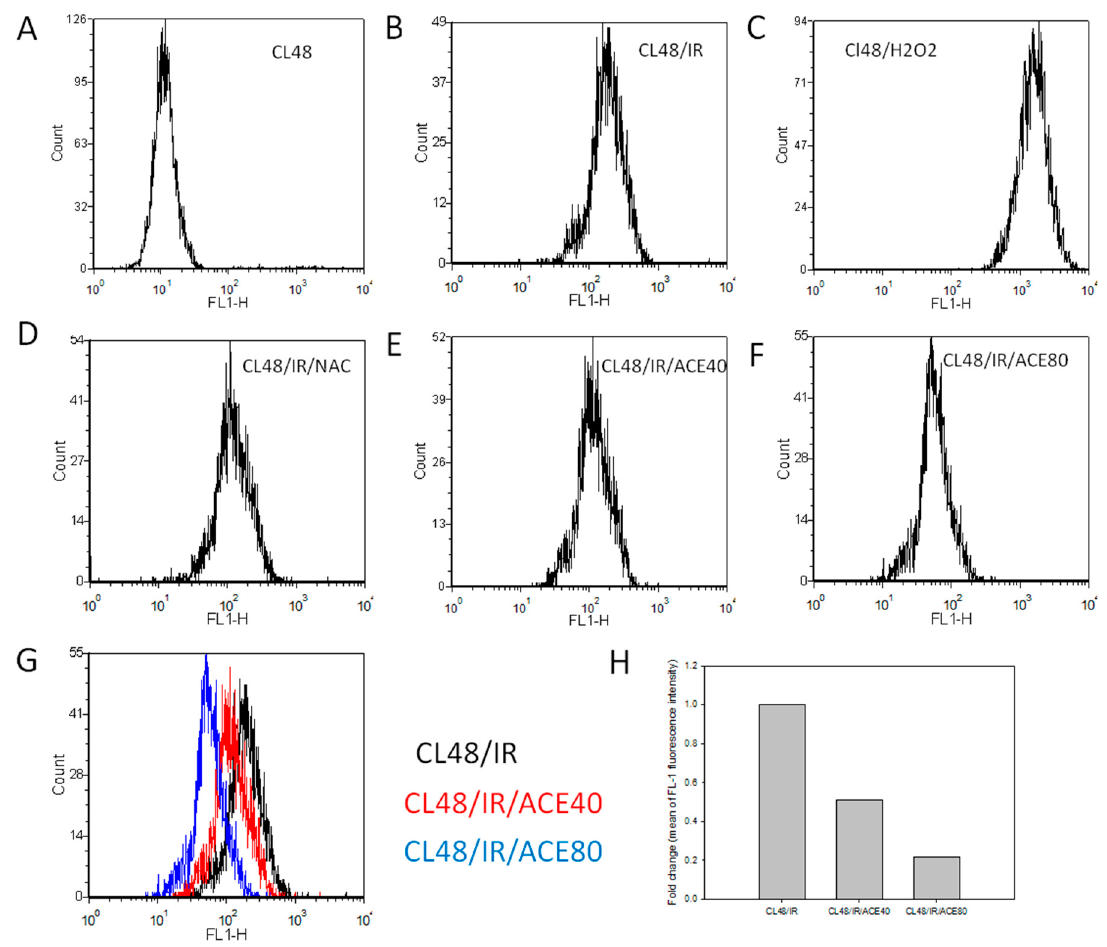
Figure 4. Reactive oxygen species (ROS) scavenging activity of ACE in CL48 cells. After being treated and harvested as described in the Materials and Methods section, cells were analyzed by flowcytometry after incubation with 2 ′ ,7 ′ -dichlorofluorescin diacetate (DCFH-DA) for 15 min. ( A ) Control cells without treatment, ( B ) IR treated only, ( C ) H 2 O 2 treated only, ( D ) pre-treated with NAC before IR, ( E ) pre-treated with ACE 40 μ g/mL before IR, ( F ) pre-treated with ACE 80 μ g/mL before IR. ( G ) Histograms of B, E, and F were combined to show the dose-dependent ROS scavenging activity of ACE. ( H ) Fold change of control fluorescence intensity by 40 μ g/mL and 80 μ g/mL of ACE, respectively.